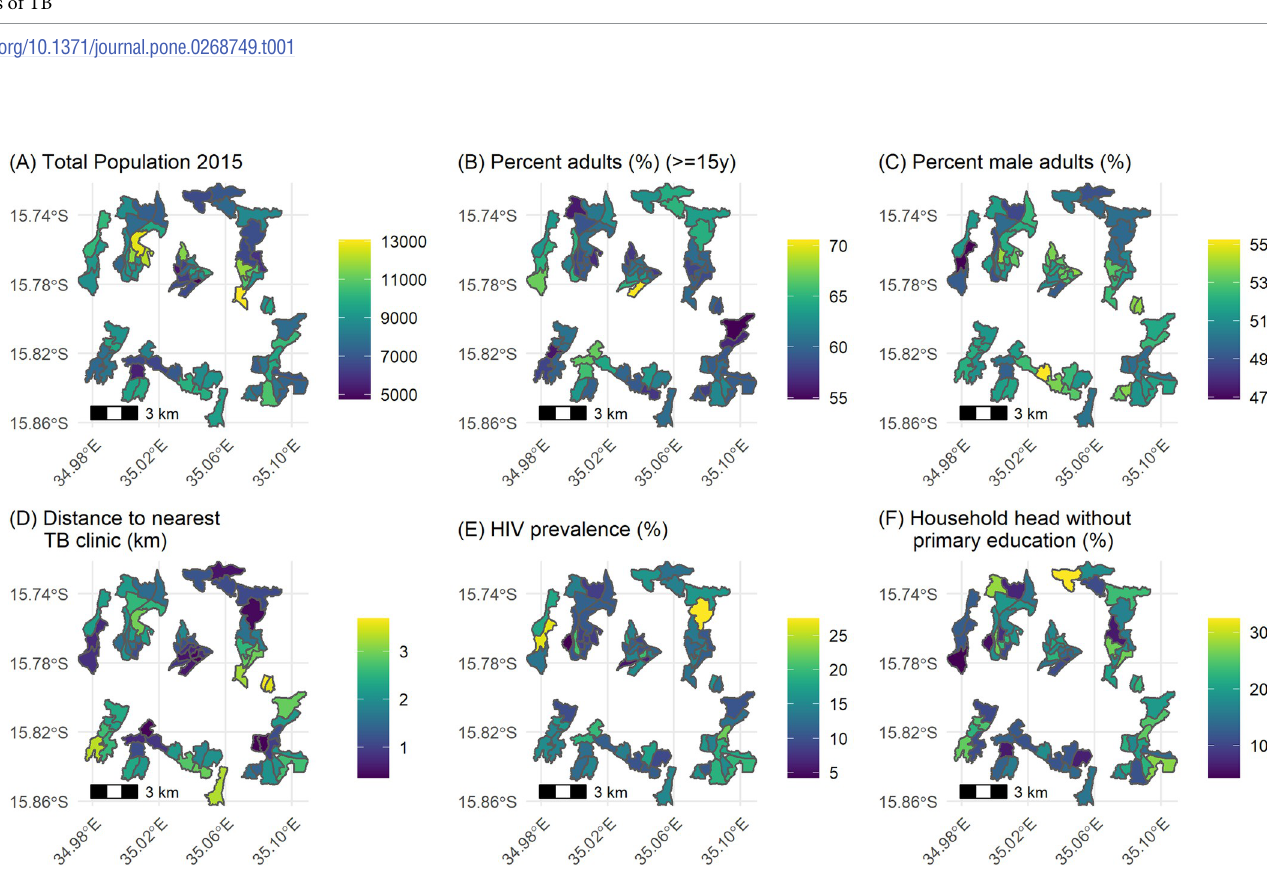
Fig 1. Choropleth maps all covariates considered in predictive models of TB case prevalence and notification